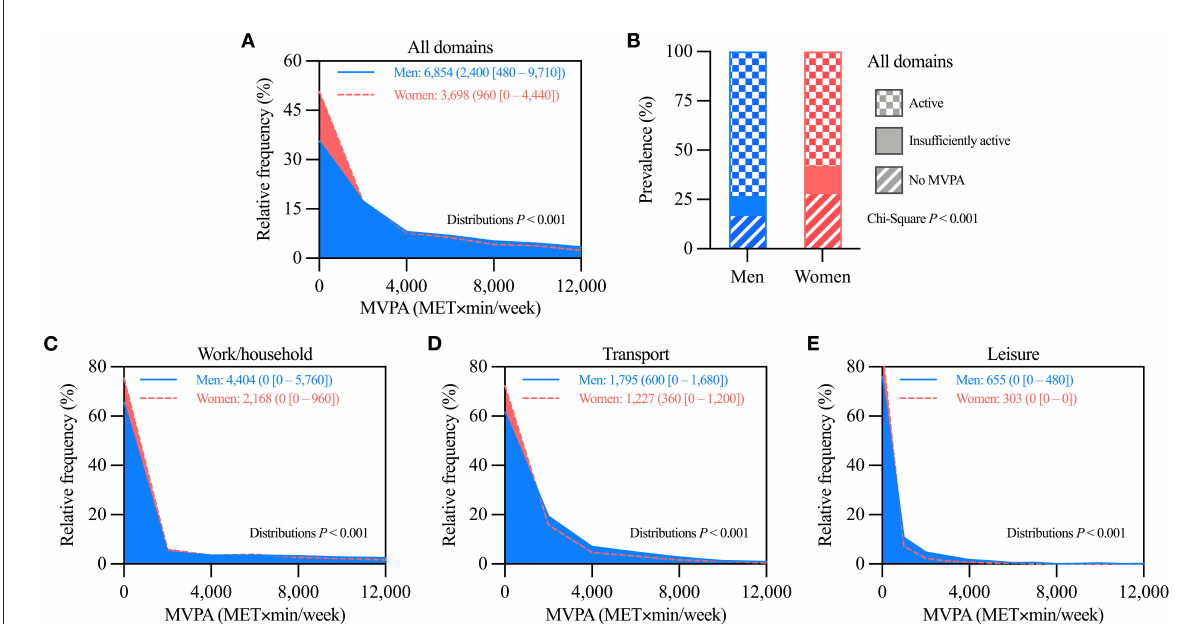
FIGURE1 Comparison of moderate-vigorous physical activity (MVPA) levels between all selected men and women. (A) Histograms comparing the distributions of MVPA considering all domains. (B) Prevalence of MVPA categories. (C–E) Histograms comparing the distributions of MVPA in the (C) work/household, (D) transport, and (E) leisure domains. In panels A and C–E , values are mean (median [25–75th percentile]) of MVPA; distributions more skewed to low MVPA values denote lower MVPA levels. n = 1,812 for men, and 3,244 for